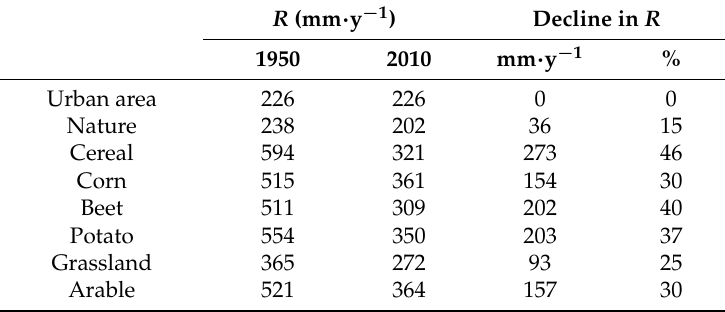
Table 5. Average groundwater recharge R in Noord-Brabant of urban area, nature, and main agricultural crops in 1950 and in 2010 according to Equation (4). The category ‘arable’ gives the area-weighted average of cereal, corn, beet potato, and grassland.